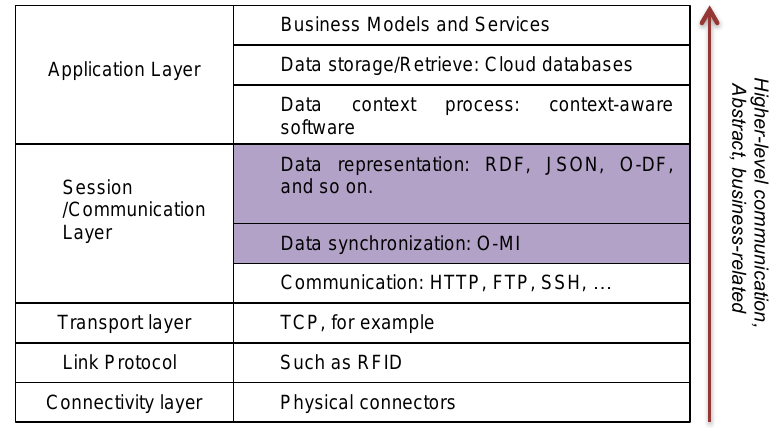
Figure 1. Product lifecycle management and information closing.